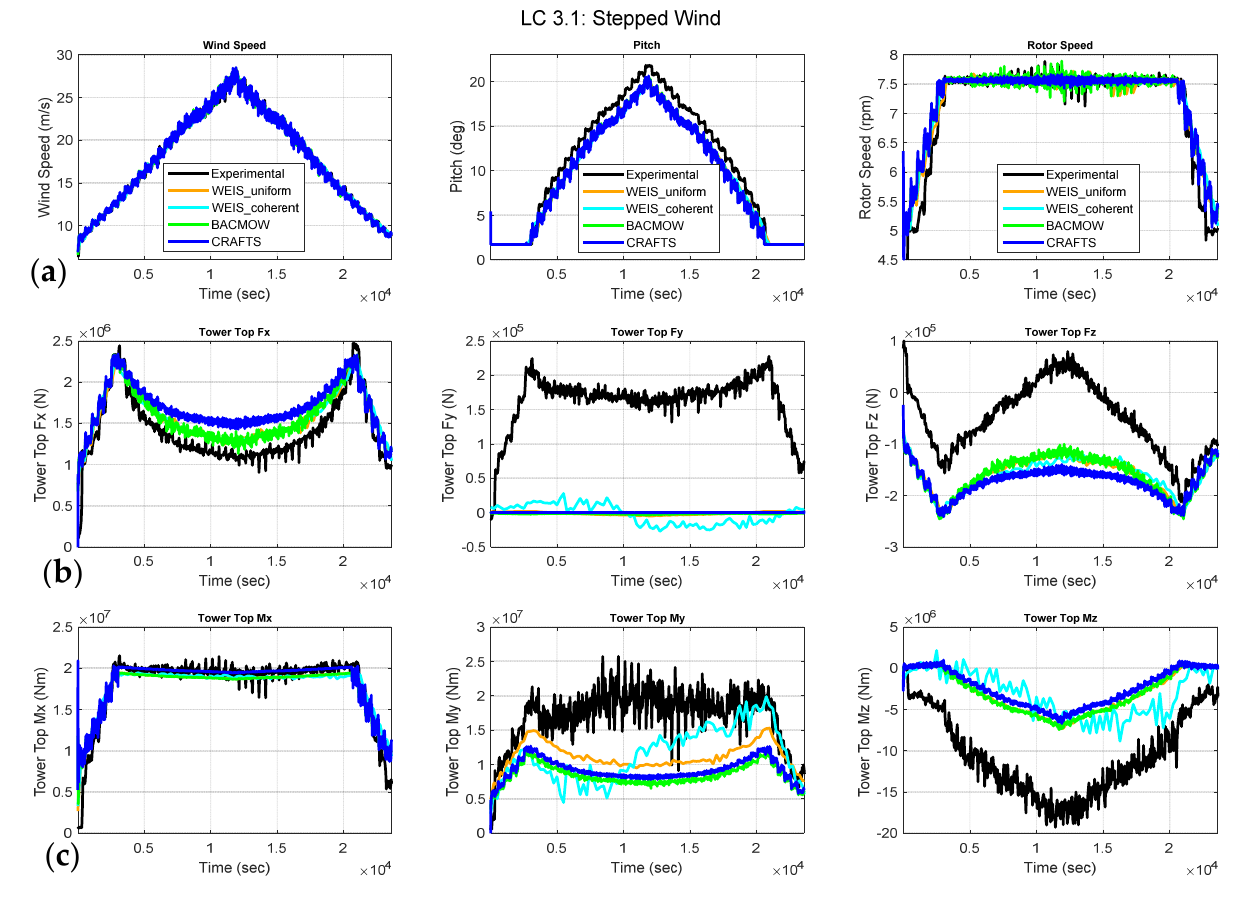
Figure 9. LC 3.1 time histories of ( a ) wind speed, blade pitch, and rotor speed; ( b ) tower top forces; ( c ) tower top moments.